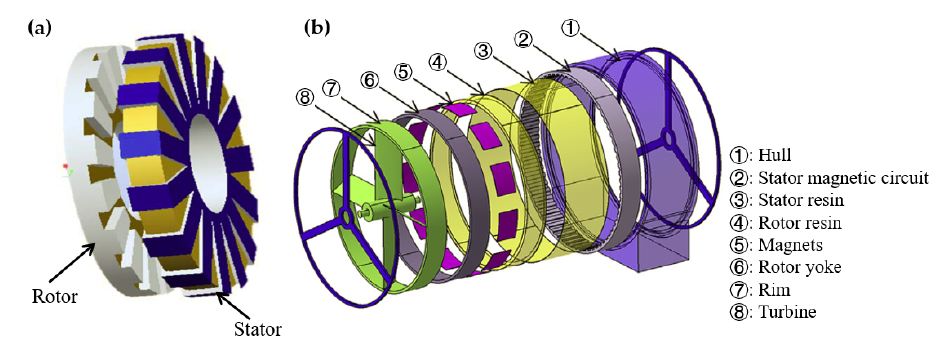
Figure 8. Schematic of DDPM synchronous generators: ( a ) a single-stator single-rotor axial-flux DDPM synchronous generator [113] and ( b ) a radial-flux DDPM synchronous generator